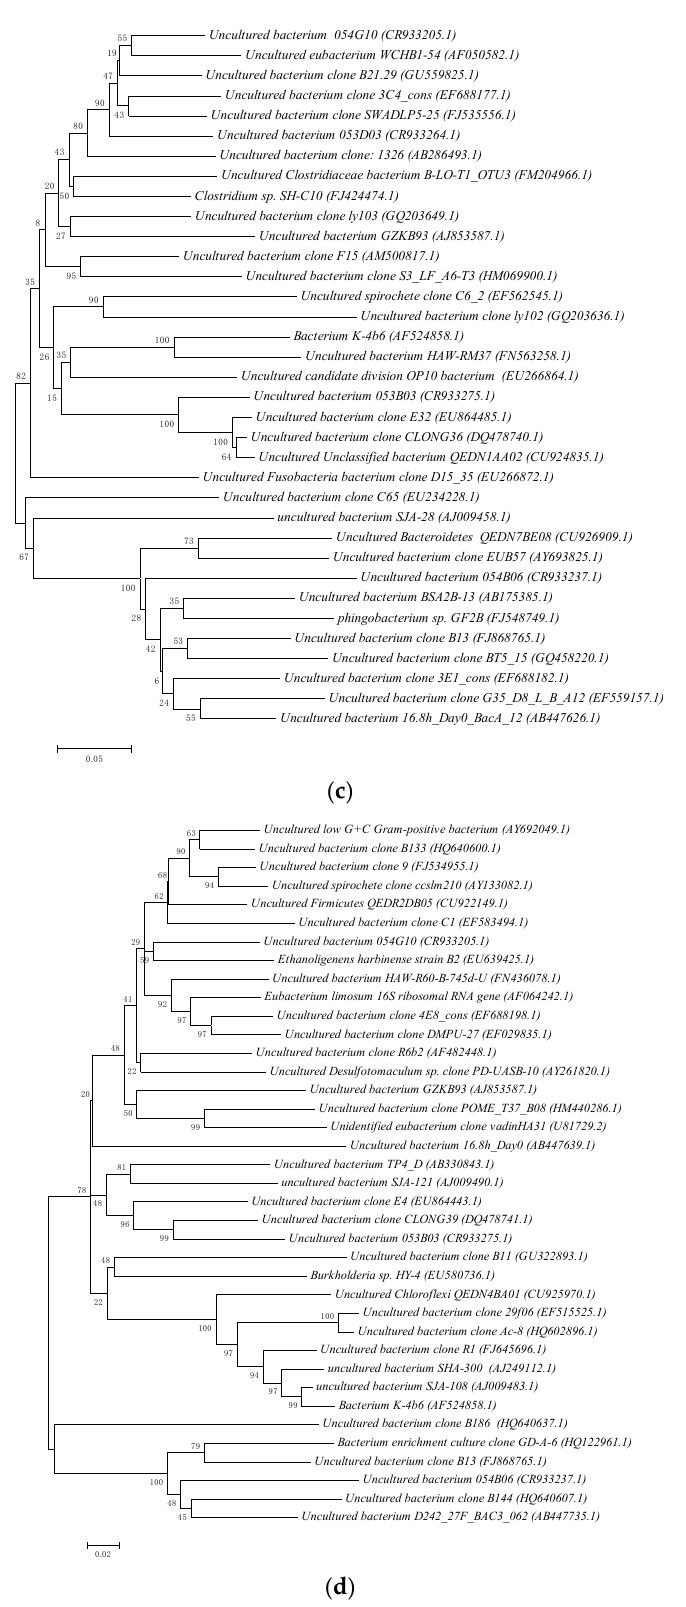
Figure 2. Phylogenetic tree for the total bacterial community in ABR chambers ( a ) chamber A1, ( b ) chamber A2, ( c ) chamber A3, and ( d ) chamber A4.